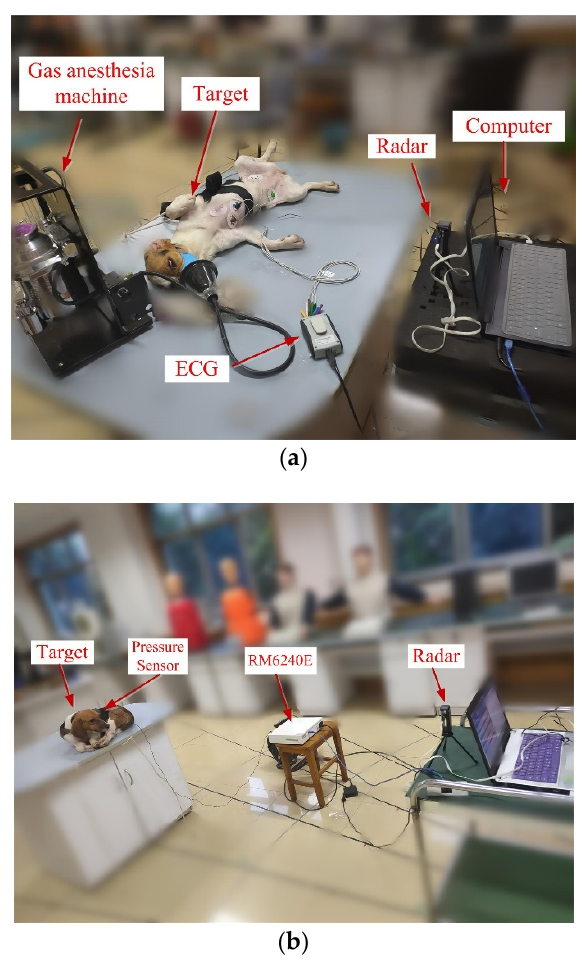
Figure 3. (a) Experimental scene when the target is under anesthesia; ( b ) Experimental scene when the target is at